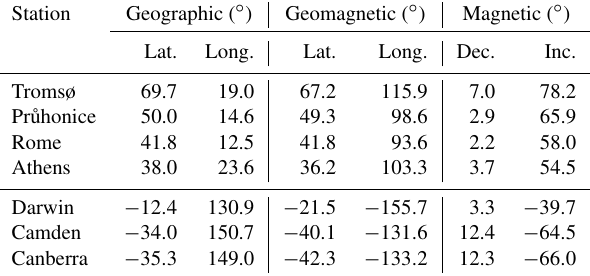
Table 2. Geographic and geomagnetic latitudes and longitudes of the European (Tromsø, Pr˚uhonice, Rome, and Athens) and Aus- tralian (Darwin, Camden, and Canberra) ionosonde stations which are used in the calculation of the delayed response of the iono- sphere to solar EUV variations. The magnetic declination and incli- nation are shown as well. The magnetic field parameters are calcu- lated with the International Geomagnetic Reference Field (NASA,